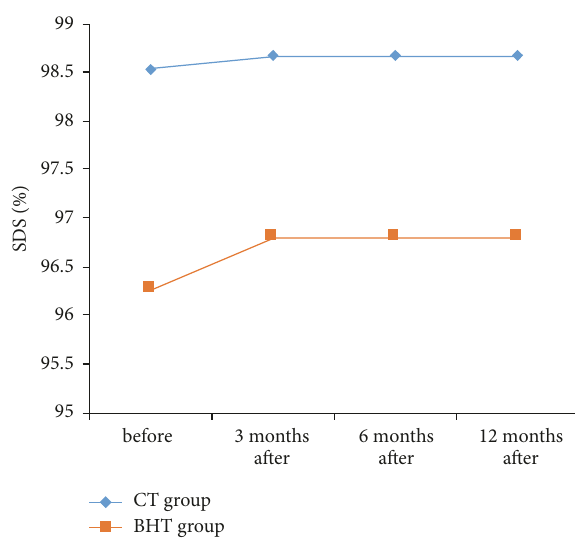
Figure 6: The trend of the change in PTA parameter in two groups.